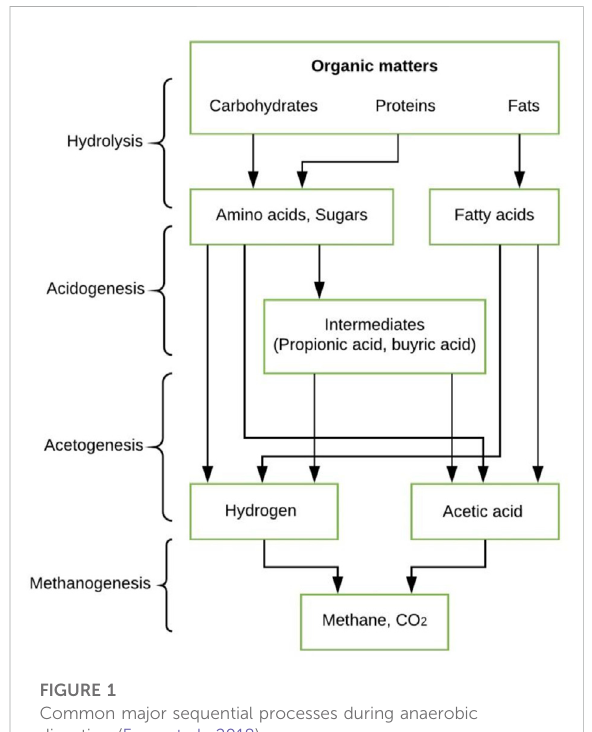
FIGURE 1 Common major sequential processes during anaerobic digestion (Feng et al., 2018).